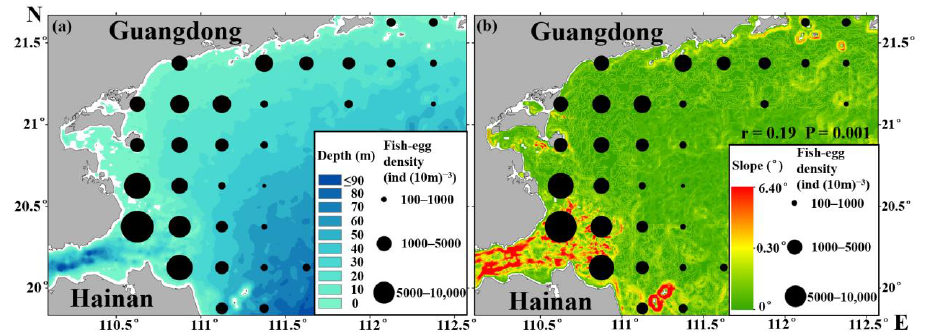
Figure 4. Relationship between the fish-egg density and spatial factors in WGWs: ( a ) distribution of water depth and ( b ) distribution of seabed slope; r, a score of Pearson correlation coefficient; and P, p -value from Pearson correlation coefficient.